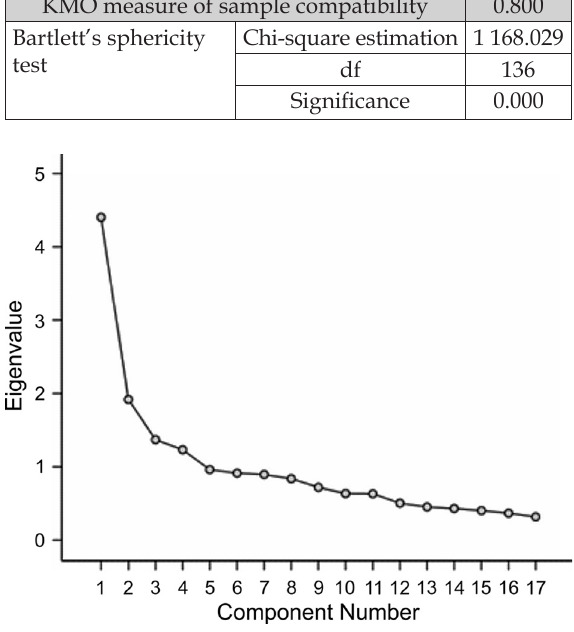
Fig. 6. The scree